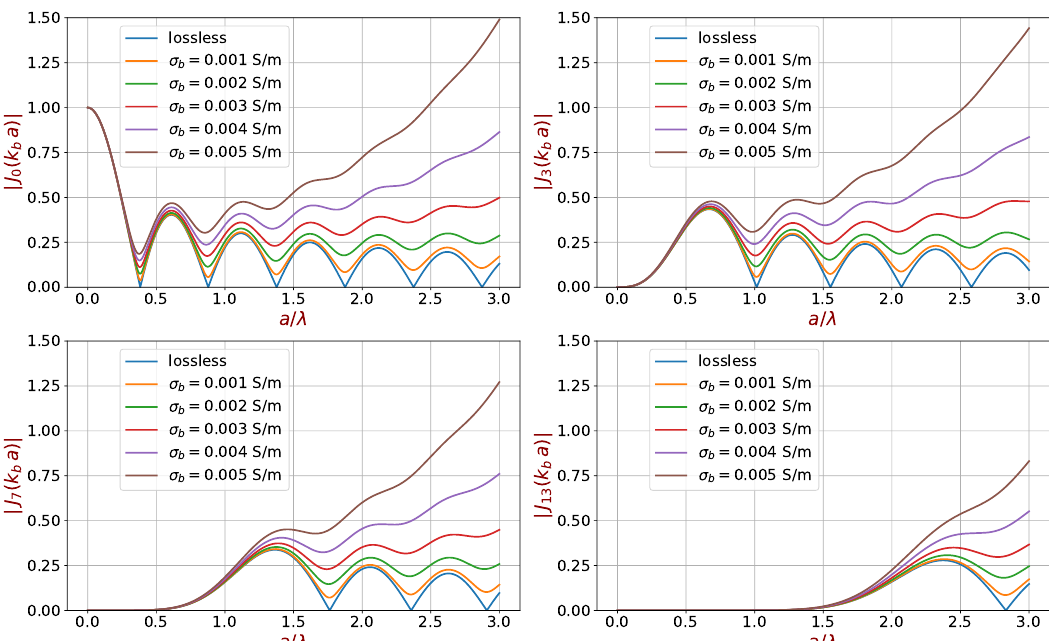
Figure 4. Behavior of the magnitude of different Bessel’s functions J n ( k b a ) for a background with ε b = ε 0 − j σ b / ω and different values of σ b , versus the radius of PEC cylinder a . In the upper left corner J 0 is